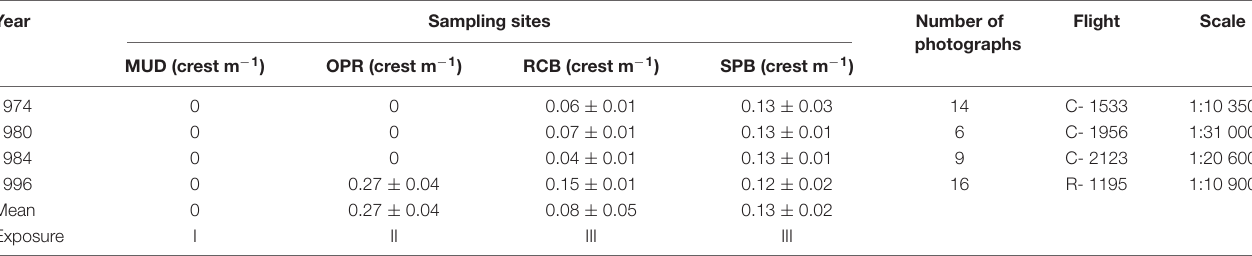
TABLE 1 | Mean waves crest per meter in sampling sites (MUD, island harbor; OPR, Old Point Regional Park of Mangrove; RCB, Rocky Cay bay; SPB, Sprat bay), using available aerial photographs for the years 1974, 1980, 1984, and